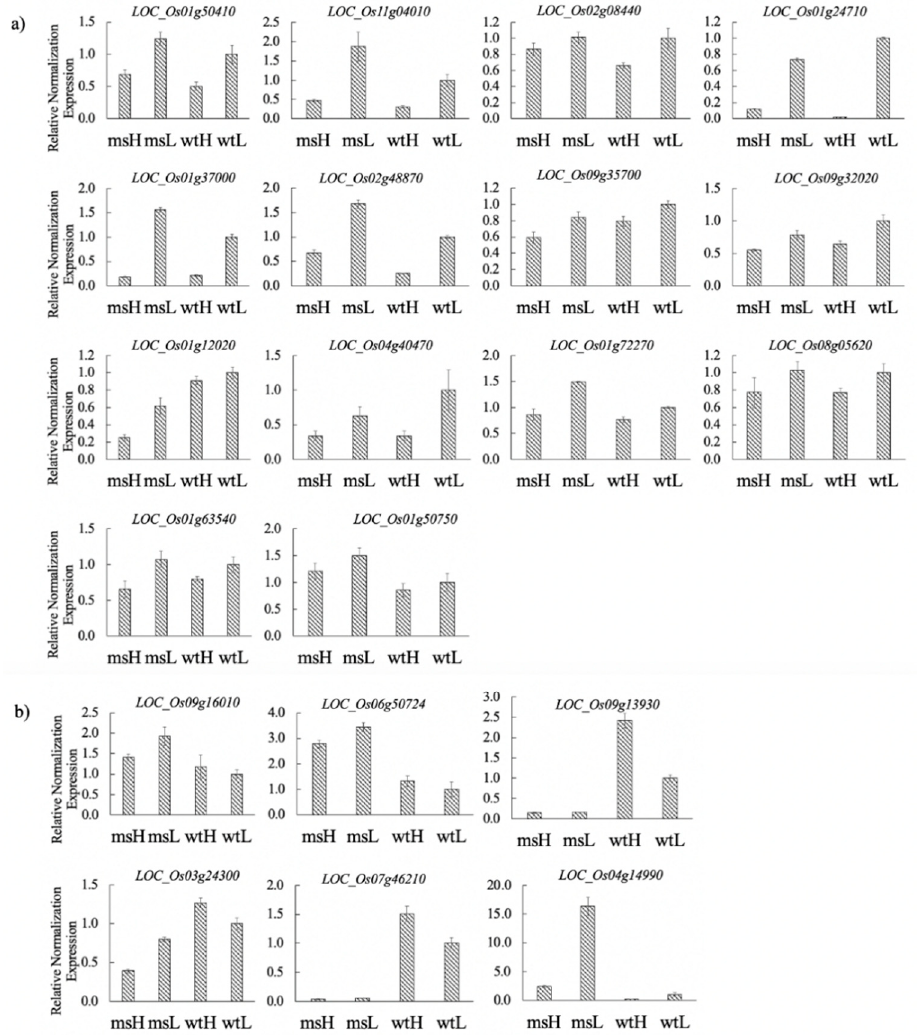
Figure 5. Genes involved in temperature alteration. Common temperature responsive genes ( a ) TGMS-related gene, ( b ) msH, TGMS under high temperature, msL, TGMS under low tempera- ture; wtH, wild-type under high temperature, wtL, wild-type under low temperature. The relative expression values were normalized to the rice actin gene . Error bars indicate standard deviation .